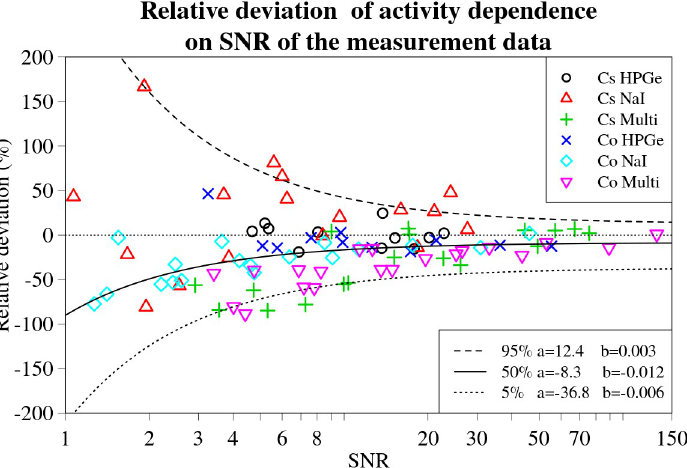
Fig 14. Activity relative deviation values for every experimental set-up, detector and source combination plotted against the respective SNR values. Black dashed line denotes the 5%, solid line—50% and dotted line—95% (from top to bottom) curves denoting corresponding quantile dependencies on SNR of the data, obtained using non-linear quantile regression. Fitted parameters a and b of the lines are displayed in a legend on the right.